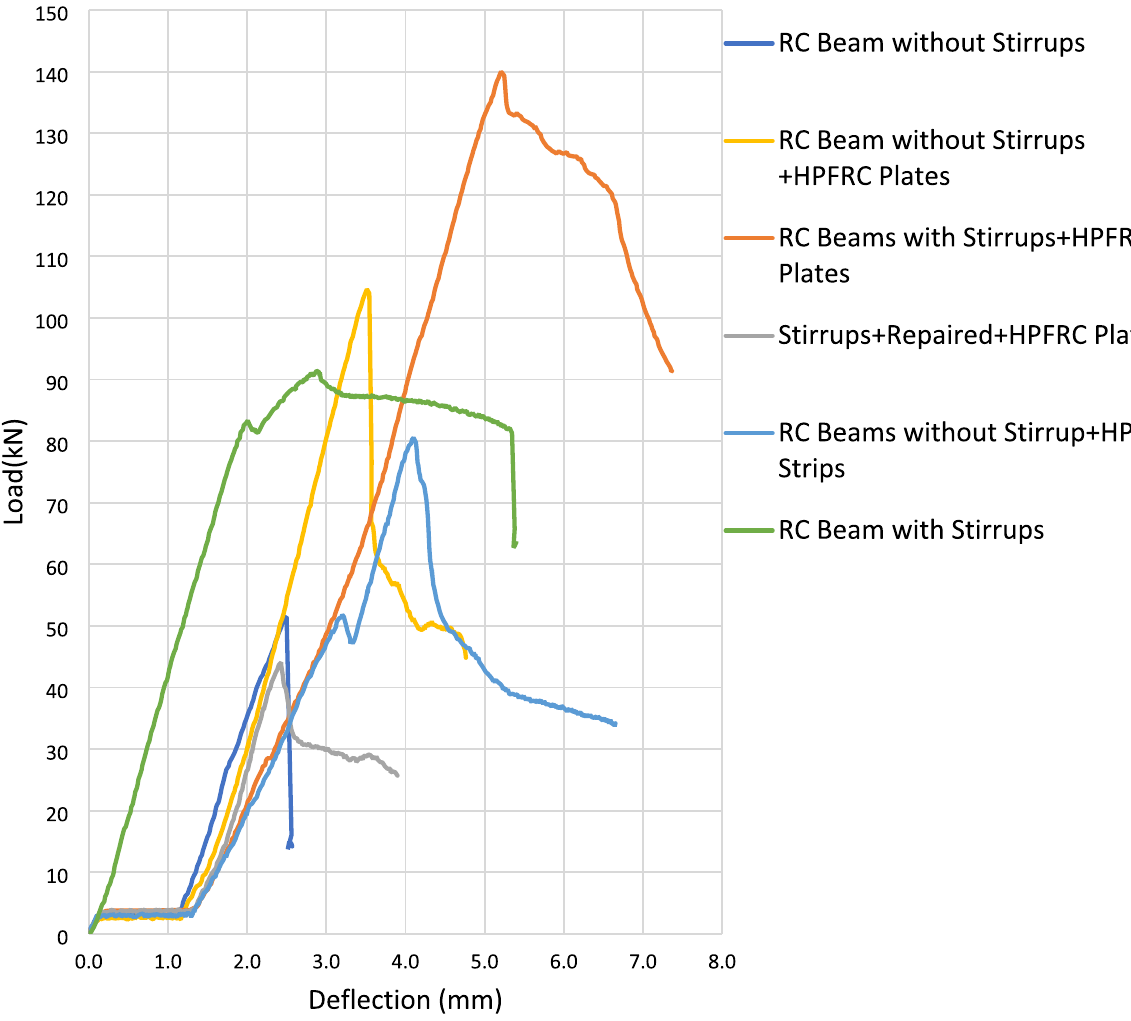
Fig. 15 Combined load deflection graph for all the